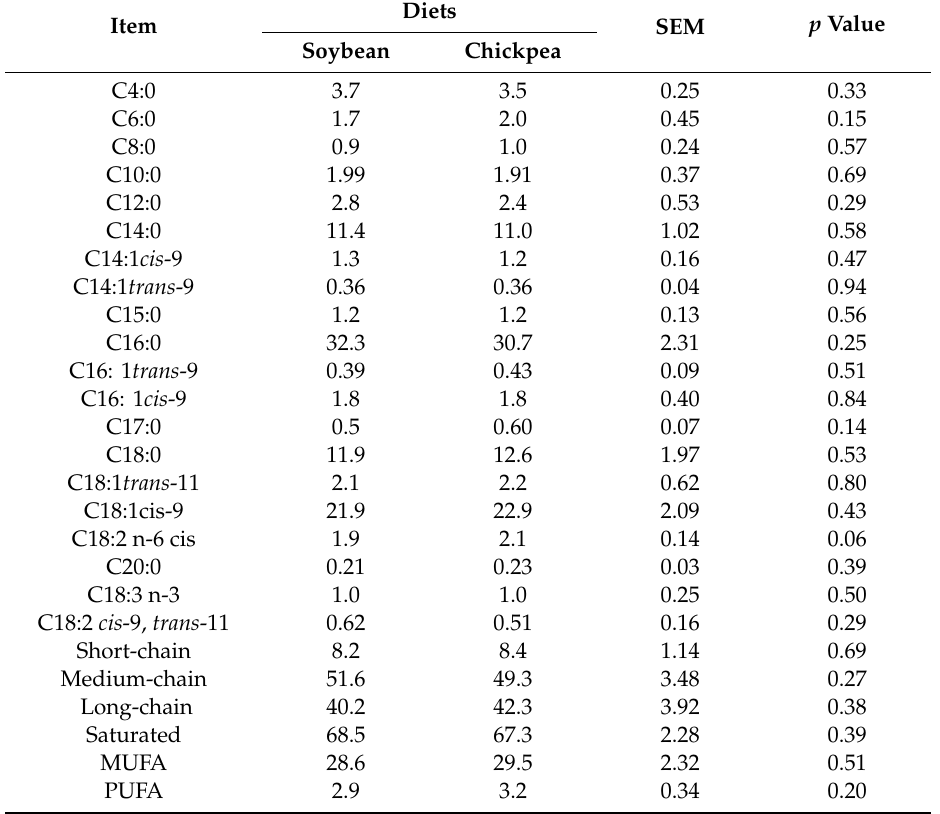
Table 5. Fatty acids composition (% of total FA) of milk (Least Squre Means) produced by bu ff aloes fed soybean meal and cickpea meal as main protein